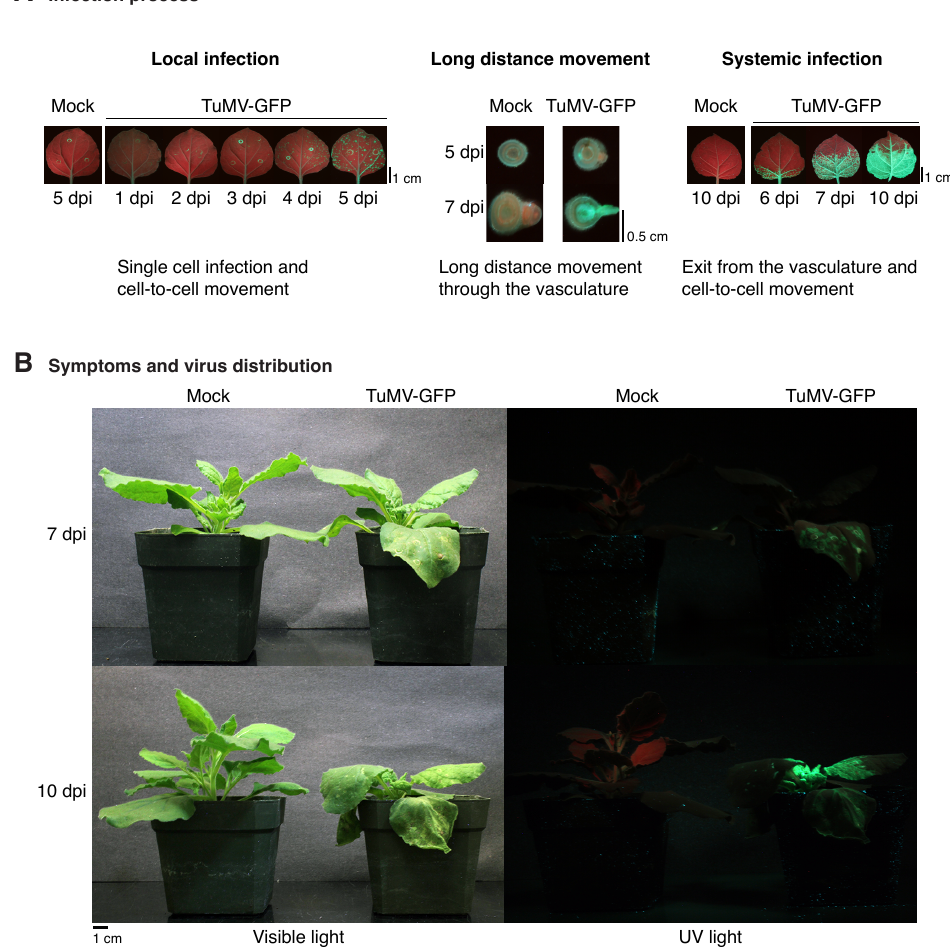
Figure 1. Plant virus infection progression, movement, and symptoms caused by virus infection. Nicotiana benthamiana plants were inoculated with GFP-tagged TuMV (TuMV-GFP) by agroinfiltration and leaves of whole plant pictures taken under visible or UV light. ( A ) Pictures showing representative local infection foci (green spots) in inoculated leaves, long-distance movement and infection of the vascular system, and progression of systemic infection in noninoculated leaves. ( B ) Symptoms of TuMV-GFP infection at 10 days post-inoculation (dpi) and distribution of virus infection as determined by UV